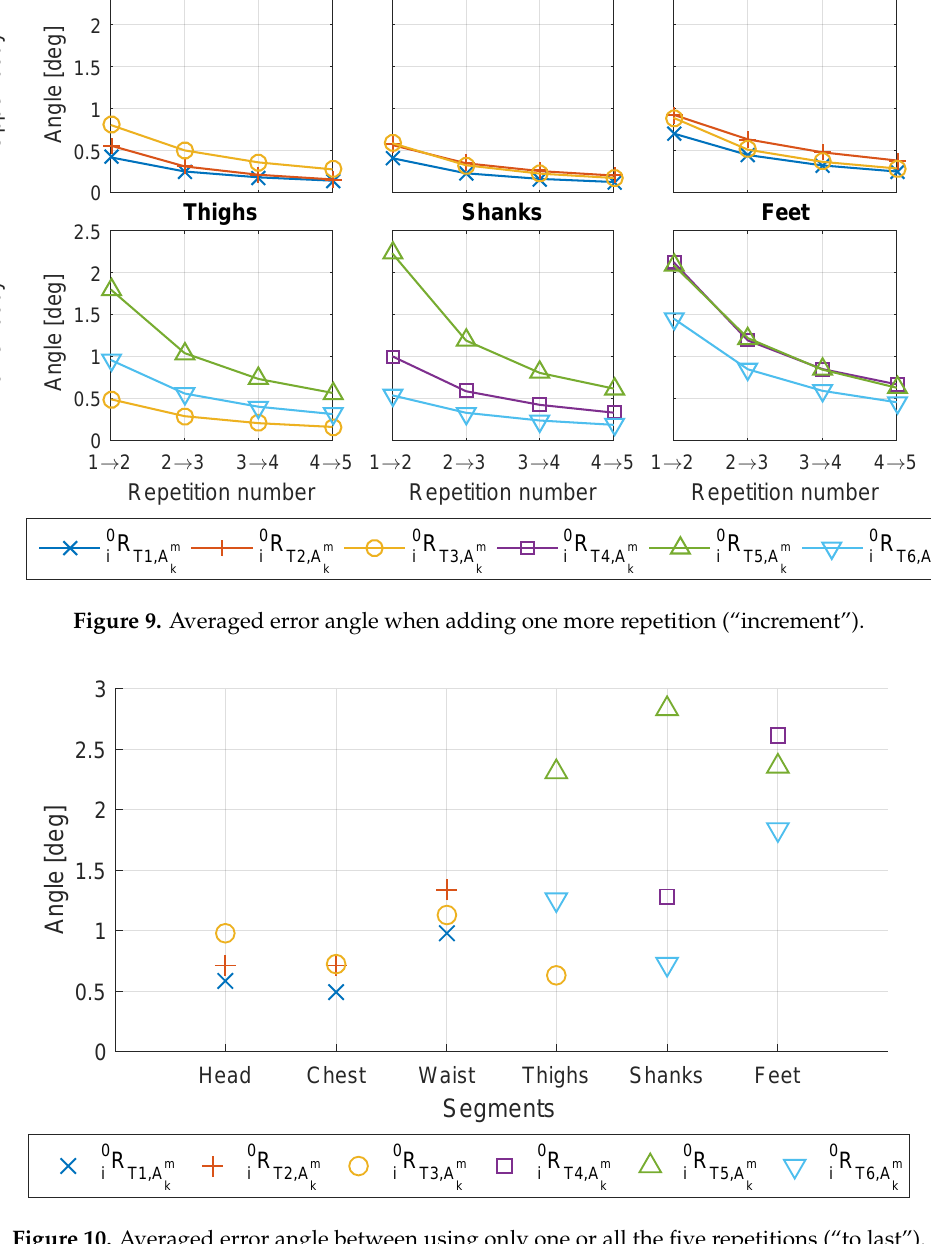
Figure 10. Averaged error angle between using only one or all the five repetitions (“to